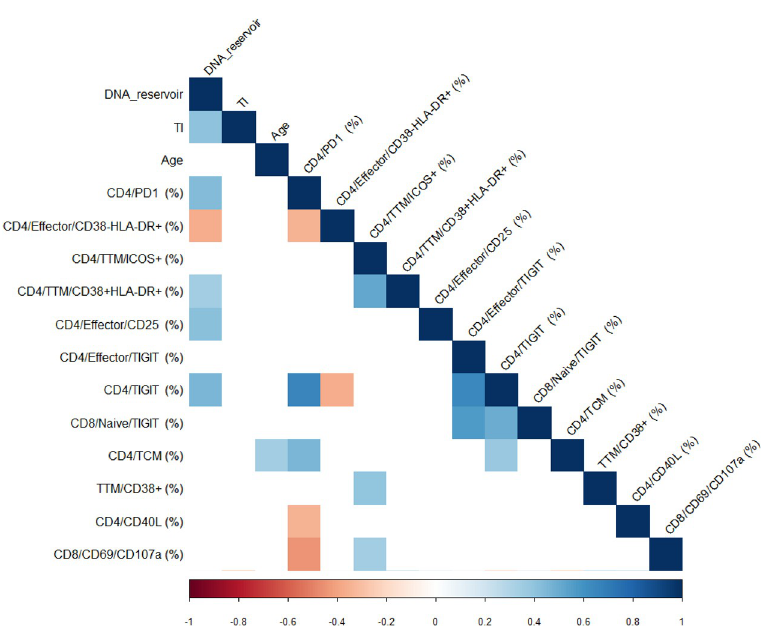
Fig 1. Correlation analysis of Predictors for HIV-1 DNA reservoir size. Correlogram showing the results of the correlation matrix of all the predictors selected by elastic net and DNA reservoir (HIV DNA), TI (Time of treatment initiation) and Age. Spearman r correlation values are shown from red (-1.0) to blue (1.0); r values are indicated by color shade. Blank fields indicate not significant correlations.